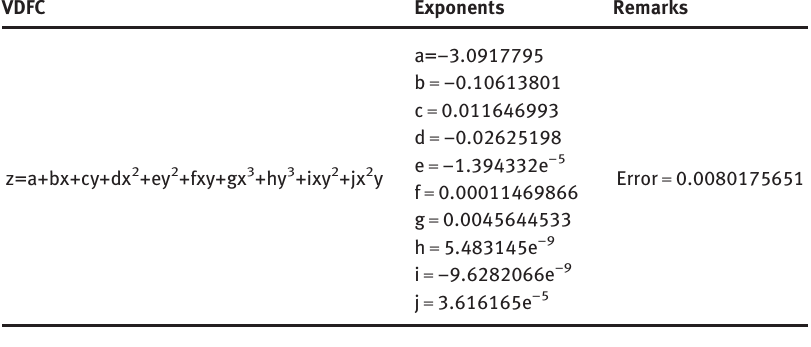
Table 1: An approximate analytical formula for the VDFC of Ti-6Al-4V alloy. VDFC